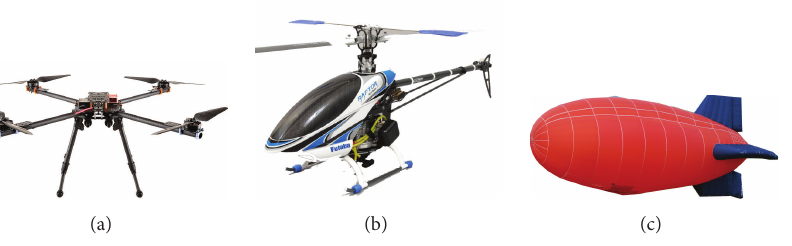
Figure 21: (a) Proposed platform. (b) Helicopter platform. (c) Balloon